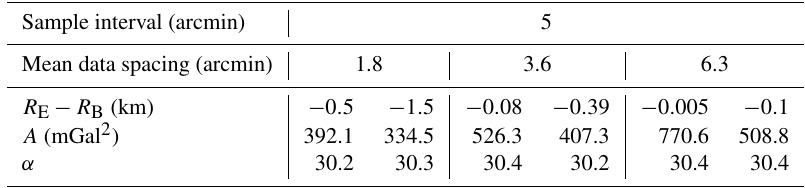
Table 13. Sensitivity of the outputs of Refined COV estimation in the region